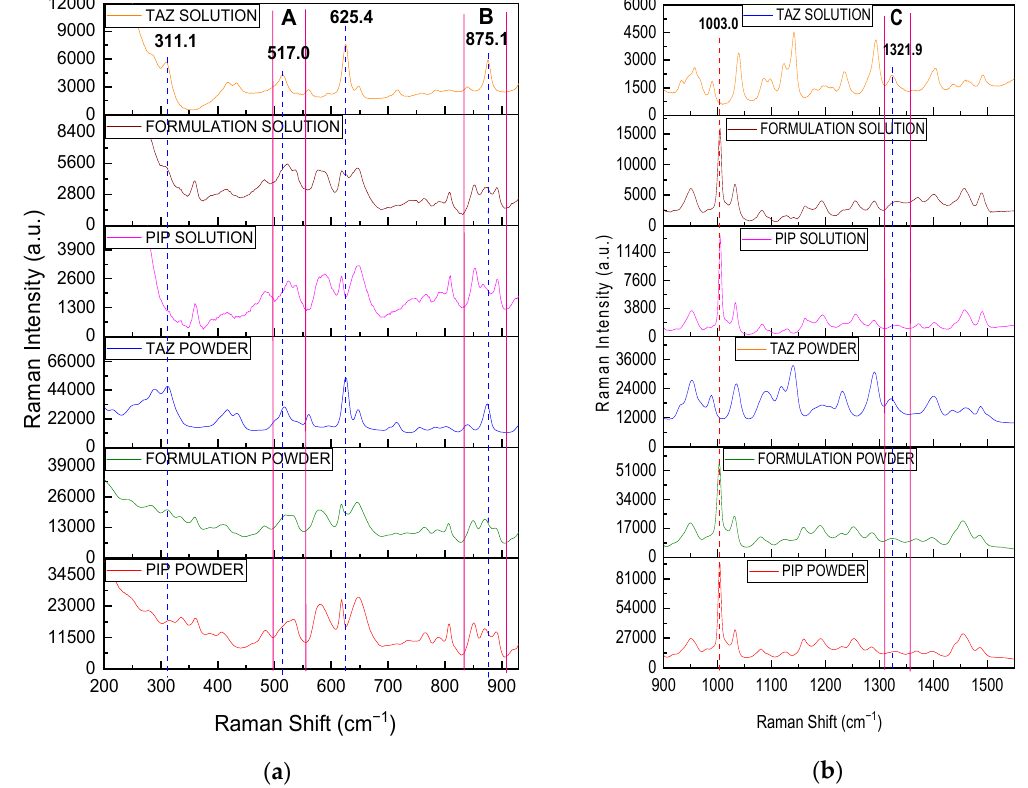
Figure 2. ( a ) Raman Spectra of PIP, TAZ, and the formulation, in both solid and liquid state: ( a ) from 200 to 930 cm − 1 and ( b ) from 900 to 1550 cm − 1 . The samples were placed on a g.slide. Differences between PIP and formulation spectra due to TAZ presence in the commercial product are shown with blue dotted lines and in the spectral regions A (494–551 cm − 1 ), B (826–906 cm − 1 ), and C (1307–1355 cm − 1 ). The characteristic peak of PIP at 1003 cm − 1 is at the red dotted line.